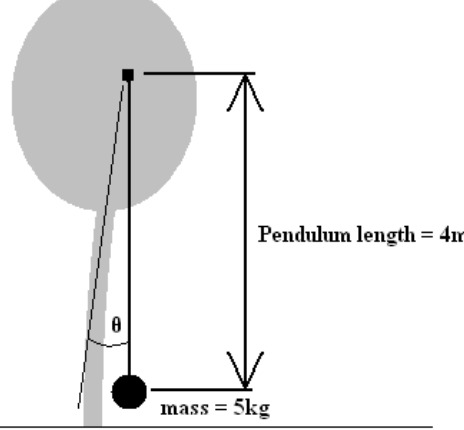
Figure 11. Theoretical arrangement of inertial harvester used for tree lean angle